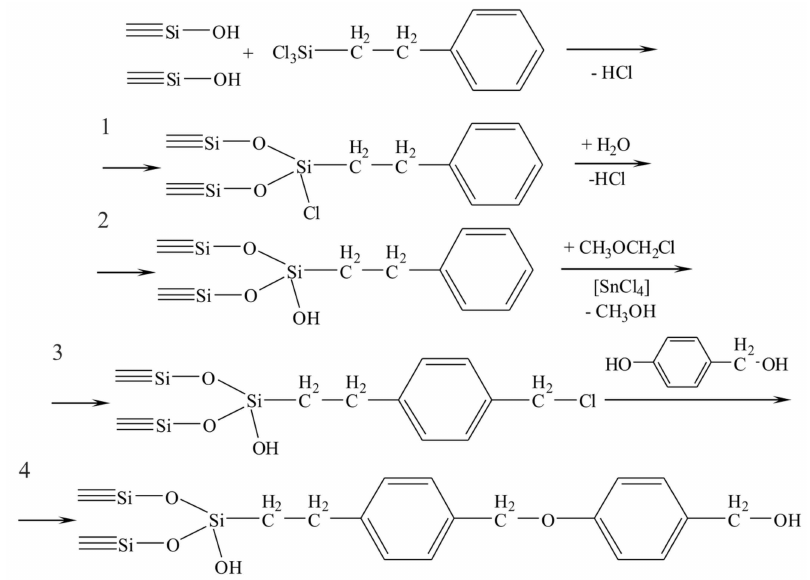
Figure 14. Scheme for the synthesis of the matrix to obtain peptides: 1, chemisorption of (2- Phenylethyl)trichlorosilane; 2, hydrolysis of chrosilyl groups; 3, chloromethylation of the aromatic ring; and 4, conjugation of p-hydroxybenzyl